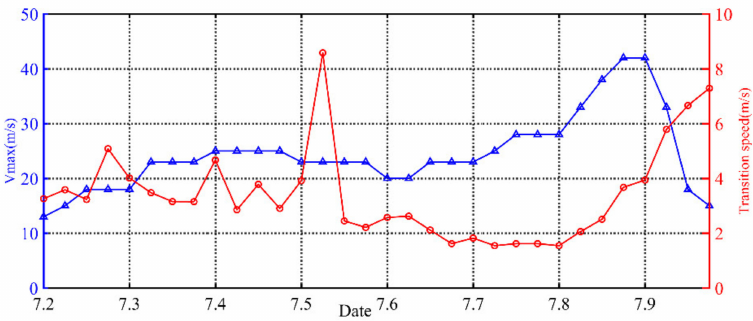
Figure 2. Time series of typhoon intensity and transition